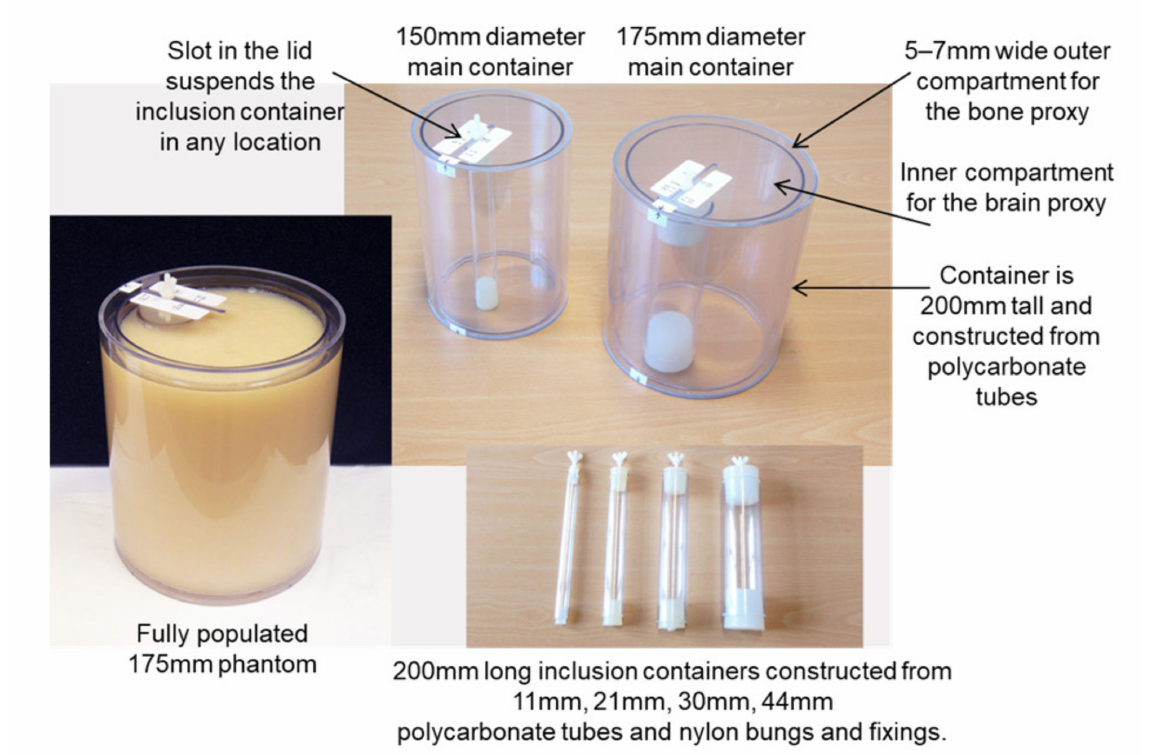
Figure 3. Polycarbonate vessels used in the construction of the